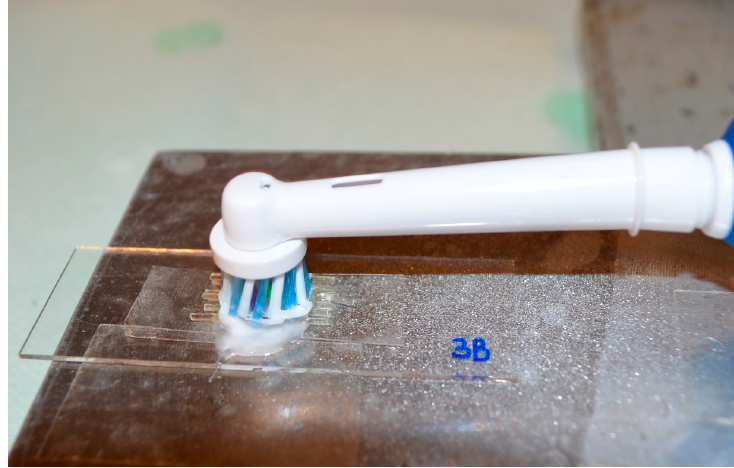
Figure 1. Brushing apparatus.